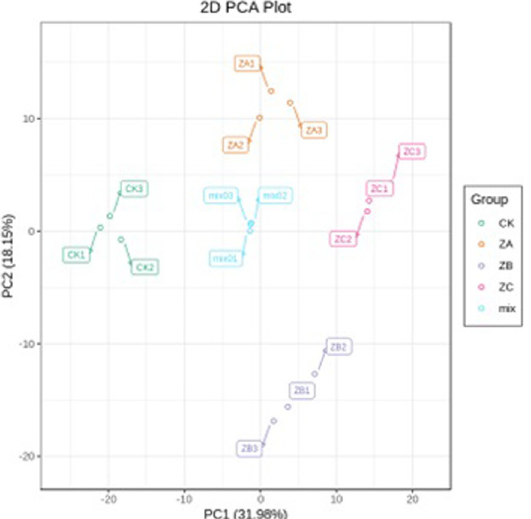
Fig 7. PCA score chart of mass spectrum data of each group of samples. Note: X axis represents the first principal component, Y axis represents the second principal component.